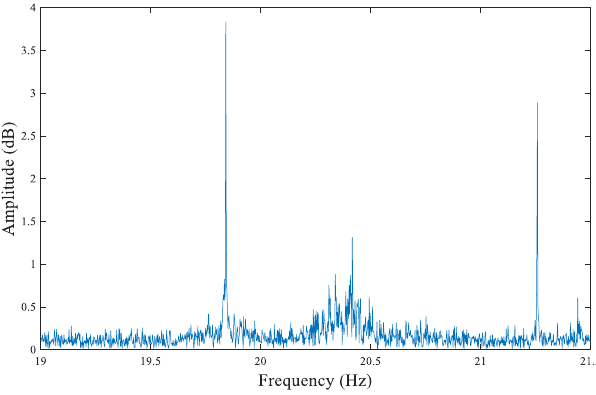
Figure 14. The signal frequency spectrum (19–21.5